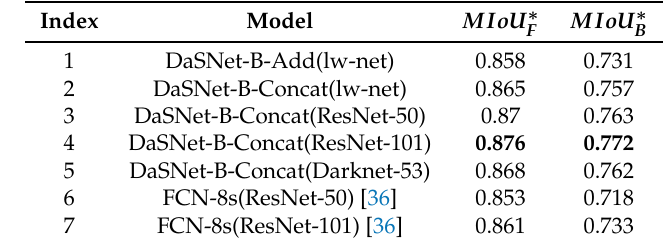
Table 5. Experiment of semantic segmentation performance on validation set (640 × 480) with GTX1080Ti ( ∗ F stands for the Fruit, while B stands for the branch).